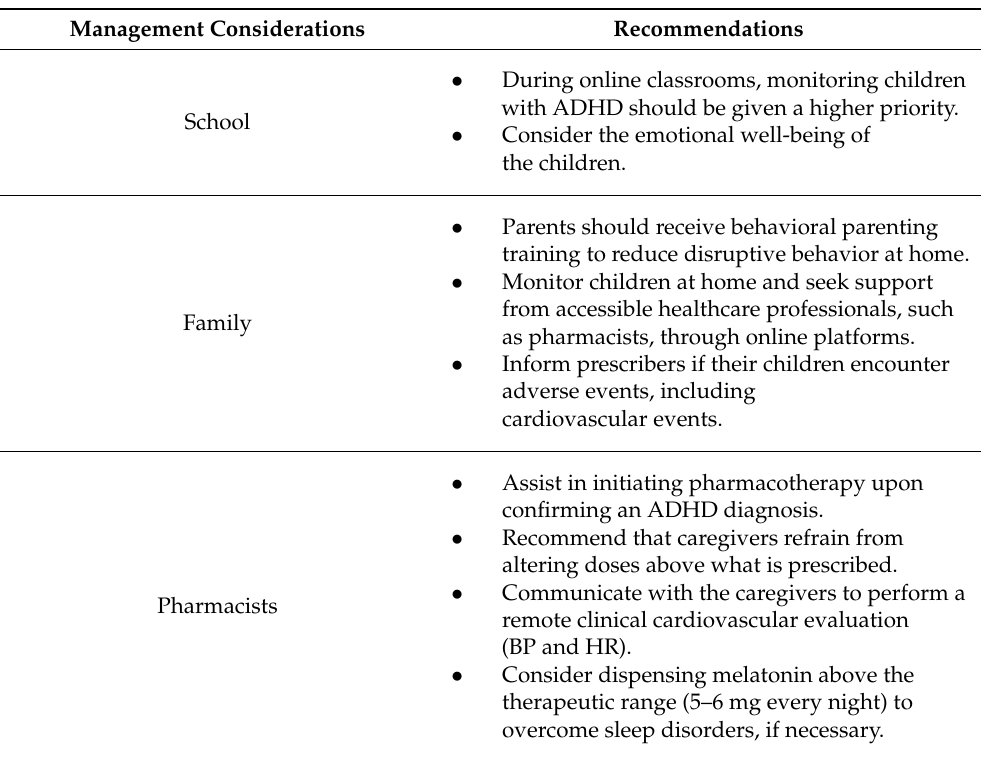
Table 3. Recommendations for ADHD management during the pandemic, according to manage- ment